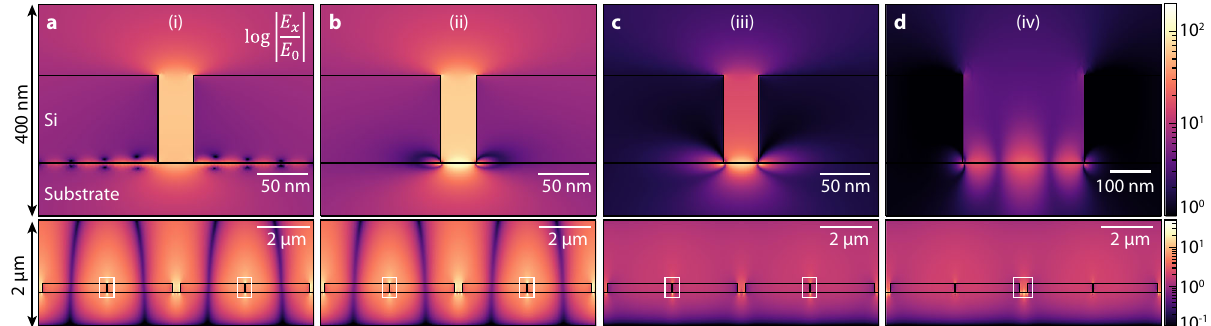
Fig. 4 The electric fi eld pro fi les of the modes. The E x fi eld pro fi les for the points (i), (ii), (iii), and (iv) in Fig. 3. Pictures on the top show close-up views of the sections enclosed by white rectangles in the bottom pictures. a The electric fi eld of point (i) showing a qBIC with a weak off-resonance graphene plasmon excitation decaying underneath the pillars. b A similar qBIC mode of point (ii), with a localized off-resonance graphene plasmon excited in Þ of point (iii) at the center of the unit cell. d The fi eld of the secondary between the pillars on the graphene ribbon. c The graphene plasmon mode ð GP 1 graphene plasmon ð GP 2 Þ mode excited on the sides of the unit cell at point